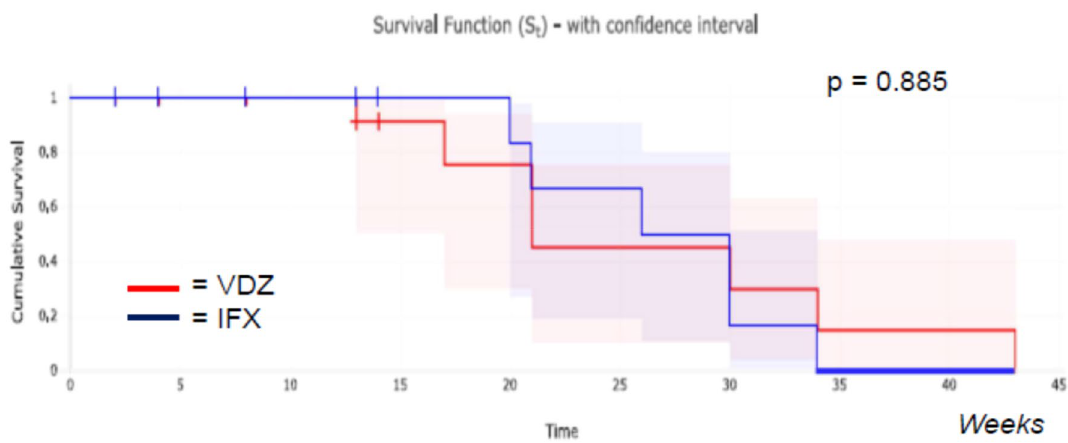
Figure 3. Time to obtain clinical remission (CR) in Infliximab (IFX) and Vedolizumab (VDZ) group, according to Weighted Kaplan–Meier